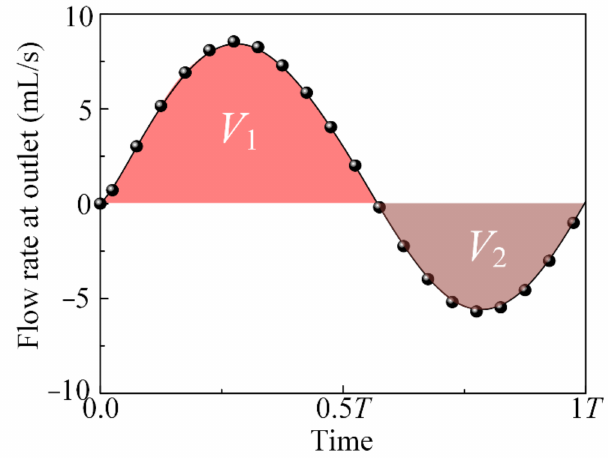
Figure 5. The pump flow rate at different